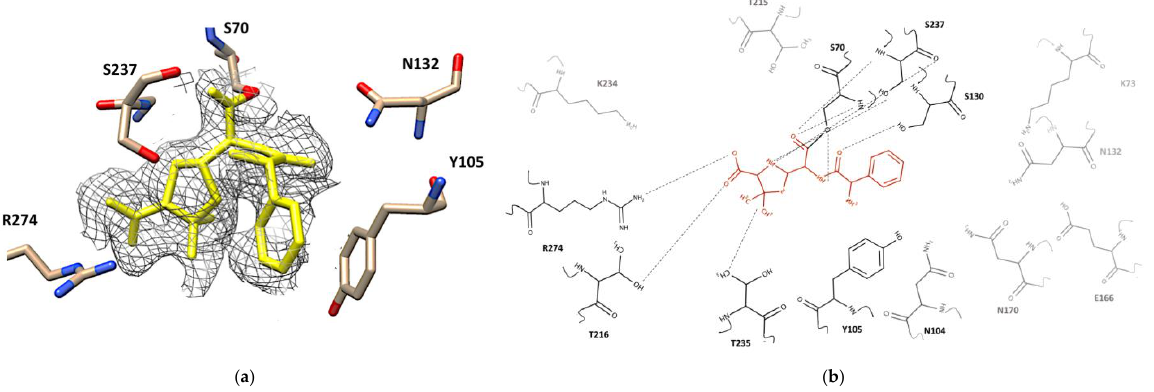
Figure 4. Active site of CTX-M-15 of the ampicillin-enzyme complex. ( a ) Electron density map of the CTX-M-15 active site bound to ampicillin in the yellow. 2Fo-Fc map (contoured at 1.0 sigma) is shown in dark gray. Residues around the binding pocket of the ampicillin -CTX-M-15 crystal structure are depicted as cream, red, blue sticks. The figure was generated with UCSF Chimera v1.13.1. (San Francisco, CA, USA). ( b ) 2D structure of ampicillin (orange) in the binding pocket of CTX-M-15. All residues have been shown, hydrogen bonds are drawn using dashed lines. The residues that interacted with ampicillin are shown in dark black, residues without interaction are depicted in gray. The figure was built by the MarvinSketch v.17.28.0. (Budapest,